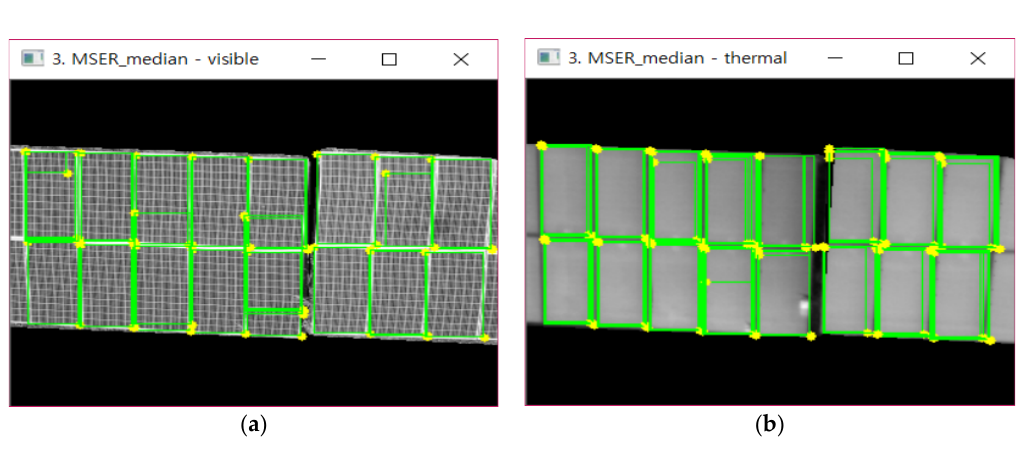
Figure 10. MSER algorithm and feature point detection result considering module size: ( a ) result of visible image; ( b ) result of thermal image.